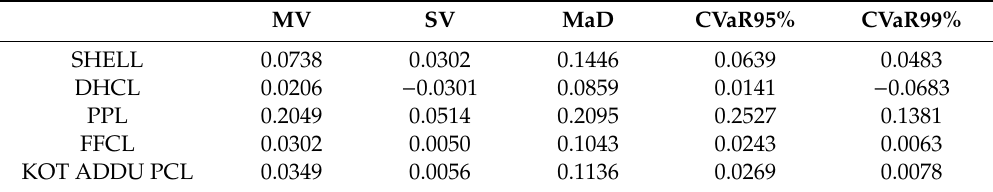
Table 2. Optimal portfolio compositions for economic recovery period (2006–2011).